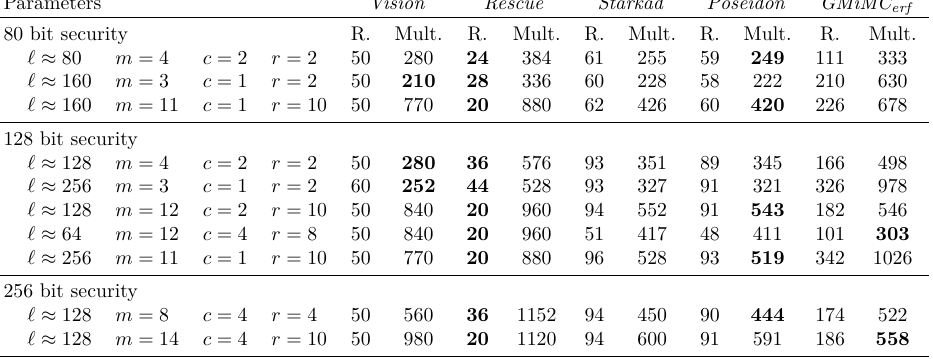
Table 4: Comparison of Vision , Rescue , Starkad , Poseidon , and GMiMC erf over MPC where ‘, c , and r are as defined for Table 2. The efficiency is given in the number of online communication rounds (R.) and number of field multiplications